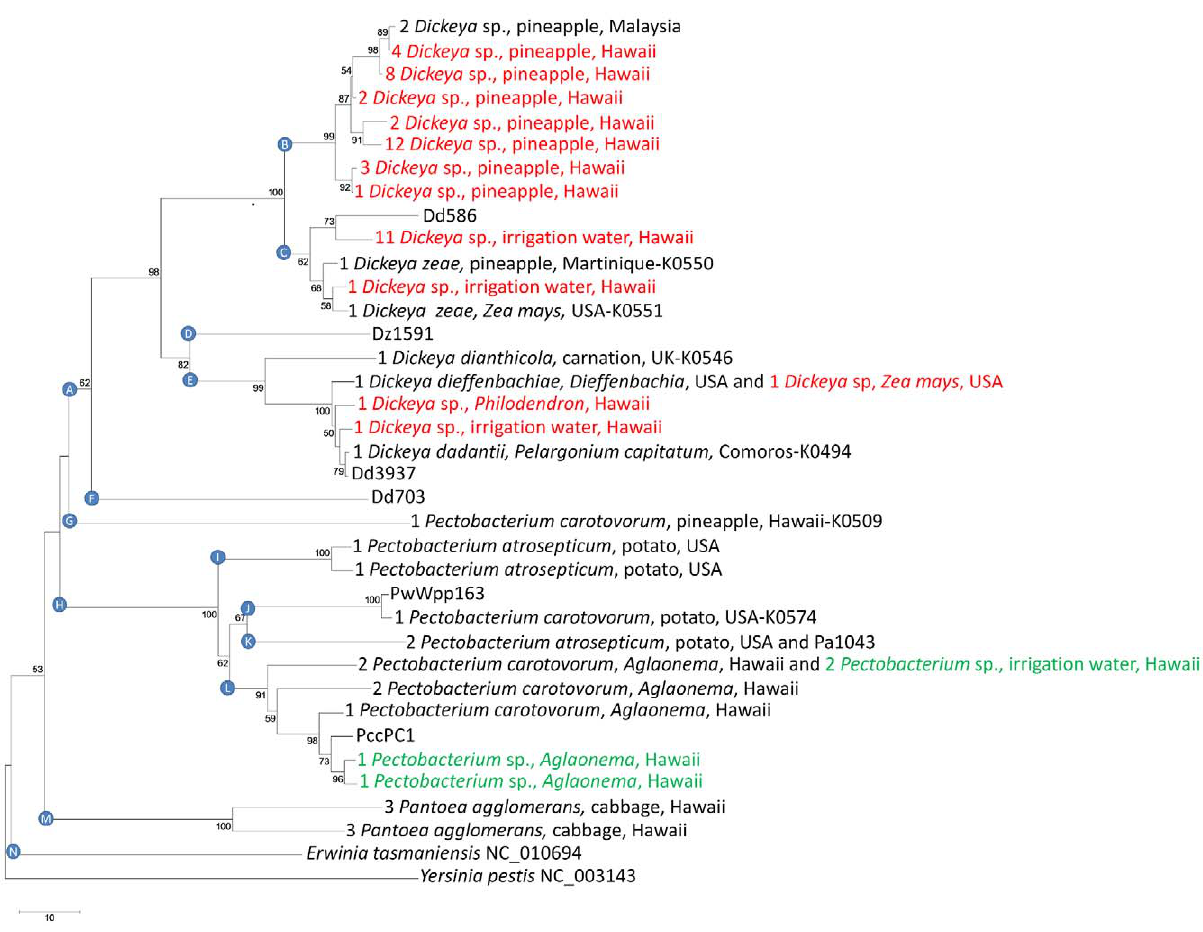
Figure 7. RIF tree of plant pathogenic Enterobacteriaceae. The rooted neighbor-joining cladogram was constructed from 74 Enterobacteriaceae strains, including 24 characterized strains of Dickeya , Pectobacterium and Pantoea from the PBC (Supplemental Table S2), eight reference strains from GenBank (see Table 1 for strain names) and the outgroup Yersinia pestis . Identical sequences are represented only once and the number of sequenced strains is indicated on each leaf. Bootstrap values . 50% (shown at the node) are expressed as a percentage of 5,000 replicates. The true Erwinia species E. tasmaniensis separates from the renamed Erwinia species that branch into three different genera: Dickeya (clade A), Pectobacterium (clades G and H) and Pantoea (clade M). Red text indicates uncharacterized strains of Dickeya and green text indicates uncharacterized strains of Pectobacterium . K numbers are shown for the accessions discussed in the text (Supplemental Table S2).